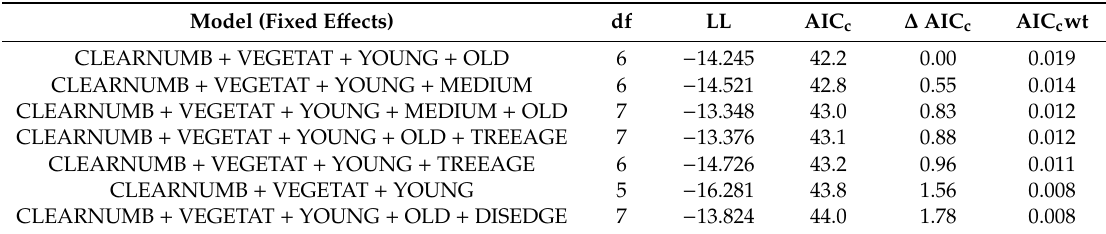
Table 2. Results of seven models describing the influence of habitat factors on Nightjar occurrence.